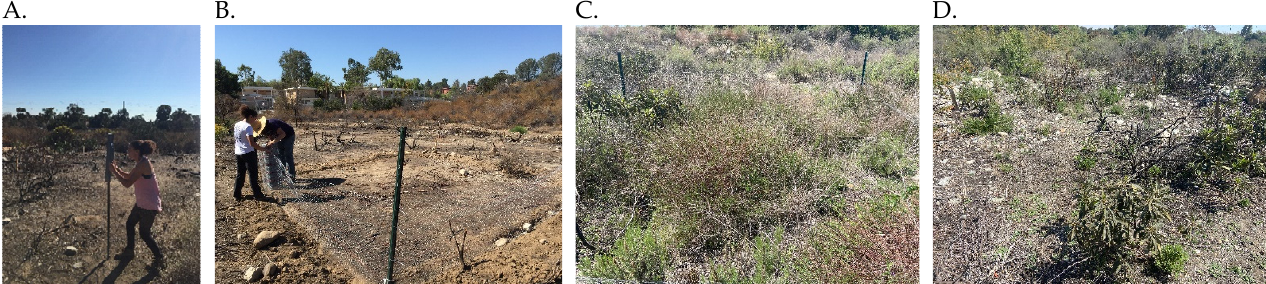
Figure 2. Pictures of our sites: ( A ) Caitlin Halligan putting in a t-post for the experimental plot in fall 2017; ( B ) Caitlin Halligan and Wallace Meyer fencing in an experimental plot to prevent herbivores access in 2017; ( C ) site six experimental plot that excluded herbivores in 2021; ( D ) the adjacent site 6 control plot that allowed herbivores access in 2021.